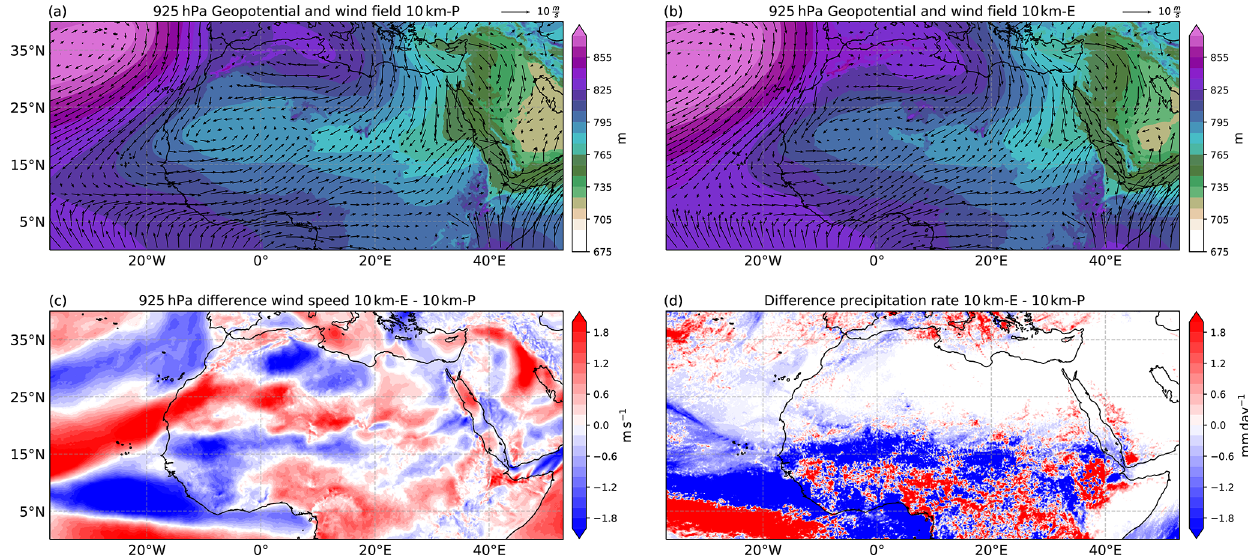
Figure A1. The same as Fig. 5 but for the 10km-P and 10km-E